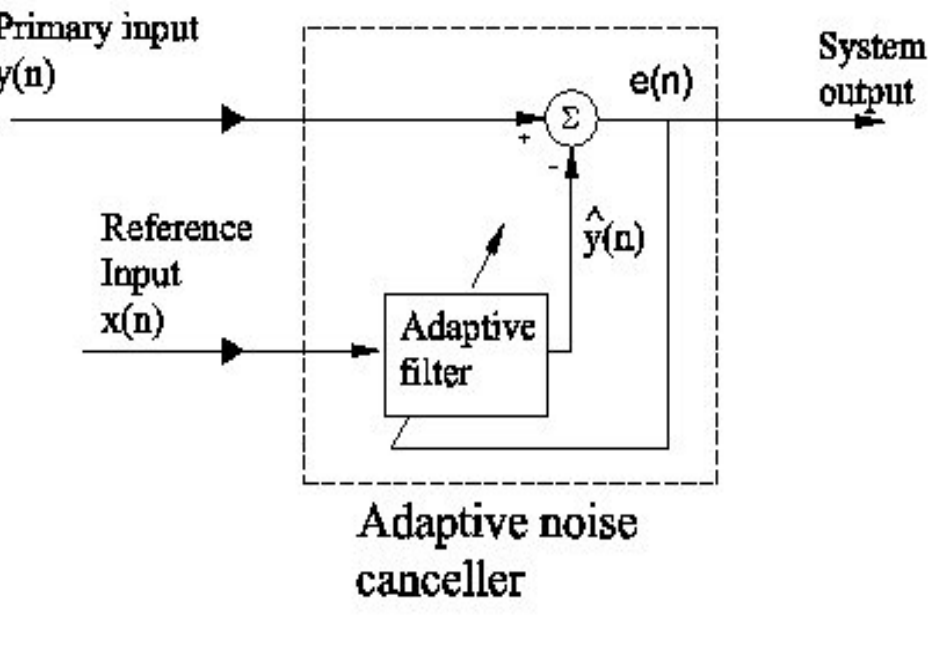
Figure 3. Block diagram representation of the adaptive